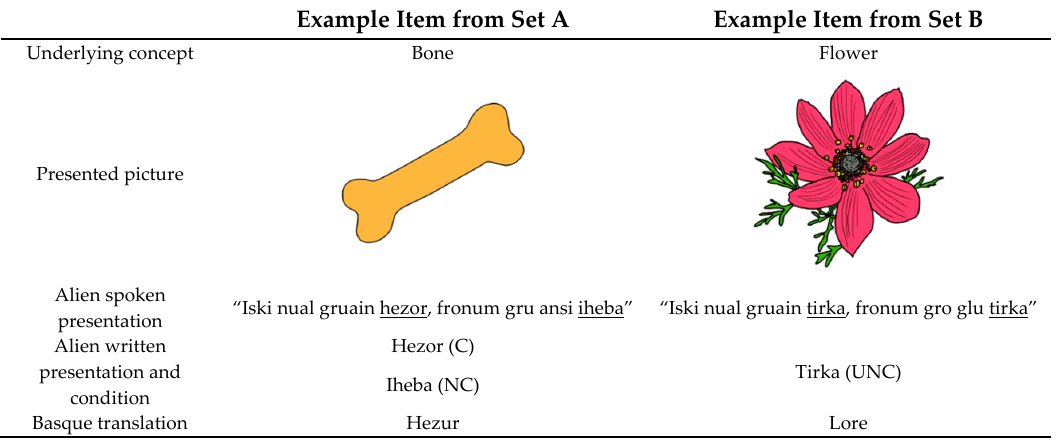
Table 1. Mean percentages of correct responses given to each condition in both recognition tasks. Standard deviation values are displayed in the second row for each condition in each task.